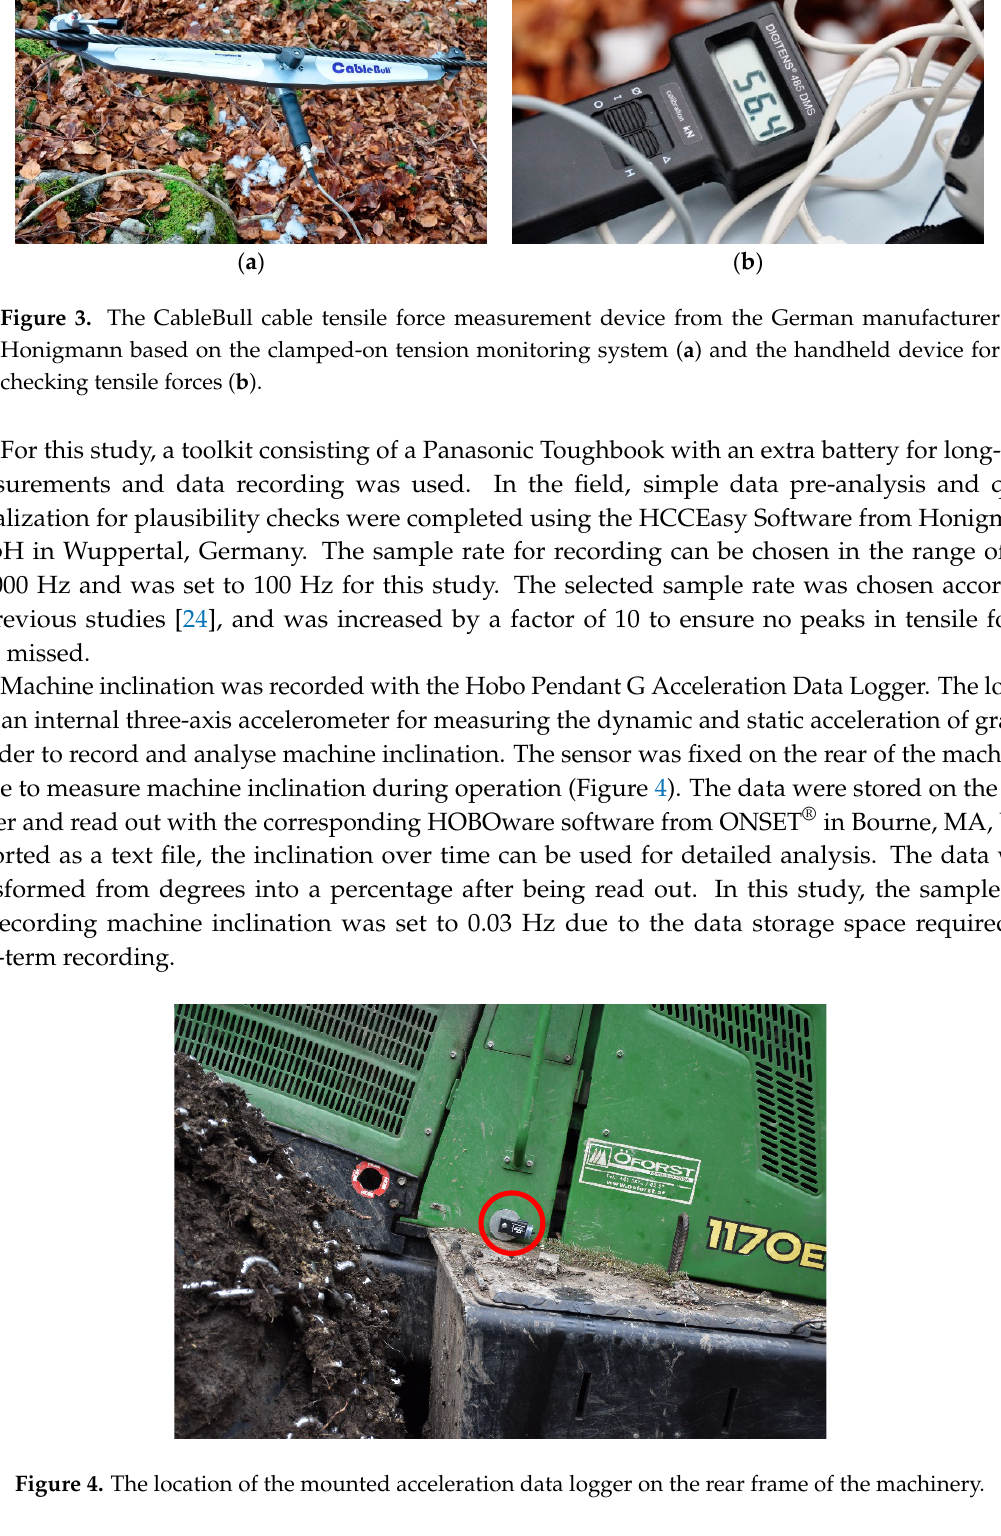
Figure 4. The location of the mounted acceleration data logger on the rear frame of the machinery.